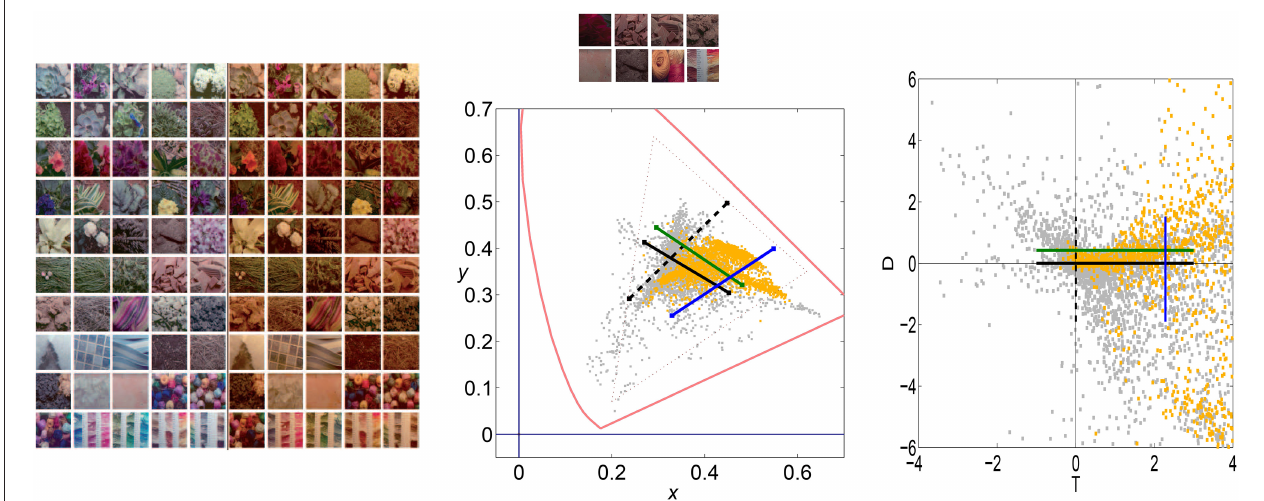
FIGURE 9 | Color datasets coming from balanced and biased reflectance sets. The large panel of color images (on the left ) shows a balanced database consisting of a diversity of objects under CIE D65 and CIE A illuminants ( Laparra et al., 2012; Gutmann et al., 2014). The colors under D65 are plotted in gray in the CIExy chromatic diagram in the center. The small panel of colored images at the top-center were selected from the D65 illumination dataset, but constitute a consistently biased world with restricted reflectance (yellow dots in the chromatic diagram). Note that the restricted set is biased to red both in the CIExy diagram (center) and in the linear Ingling and Tsou space (right) . Black lines represent the stimulation of the T or D sensors (in solid and dashed style, respectively) in a situation in which the other sensor gives no signal (appropriate for an average gray world). Colored lines represent the stimulation of the T or D linear sensor (in green and blue, respectively) in a situation in which the T and D linear sensors have positive response (a red-yellowish